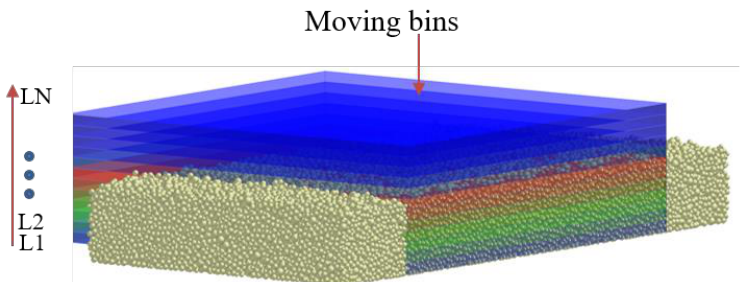
Figure 9. Original particle bed.